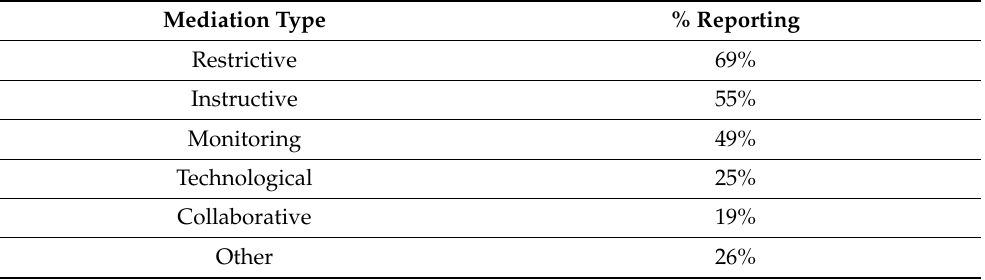
Table 3. Types of parental mediation strategies reported in the reviewed